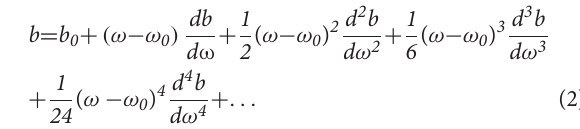
TABLE 1 | The simulation parameters employed in the design of 16/160-Gbps WDM-RoF system. Transmitter